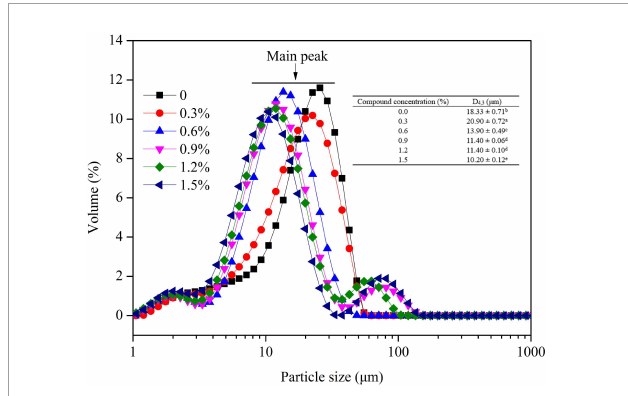
FIGURE4 Droplet size of the emulsions with different concentrations of compound fibers. The data are expressed as the mean ± standard error. Values with different lowercase letters are significantly different ( P < 0.05).